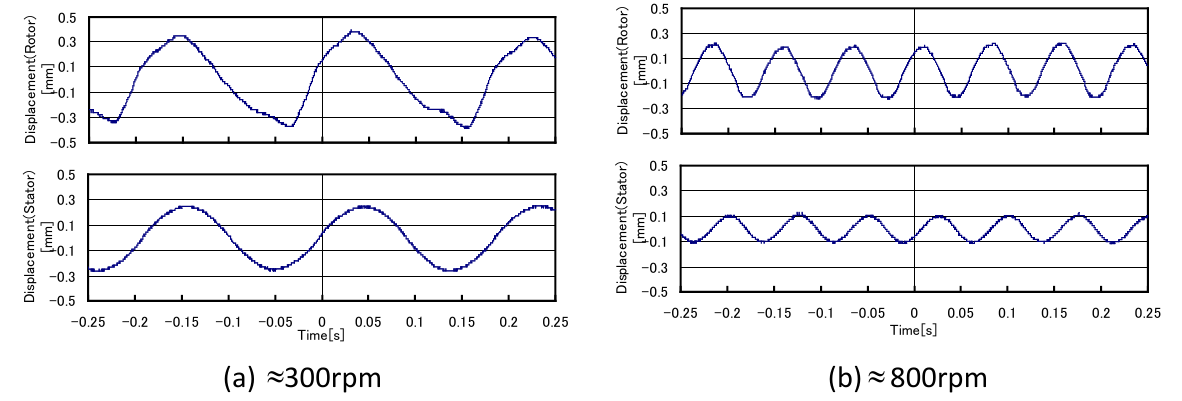
Figure 9. Free-run experimental results representing ( a ) the displacements of the flywheel rotor (upper figure) and stator (lower figure) at a speed of ≈ 300 rpm and ( b ) displacements of the flywheel rotor (upper figure) and stator (lower figure) at a speed of ≈ 800 rpm. Since the displacement of the stator is caused by the vibration of the flywheel rotor, some experiments are performed with the stator fixed to the ground base. Figure 10 shows the schematic illustration of the flywheel energy storage system in the case of a fixed stator. As shown in the figure, the stator is fixed to the base ground using some woods.